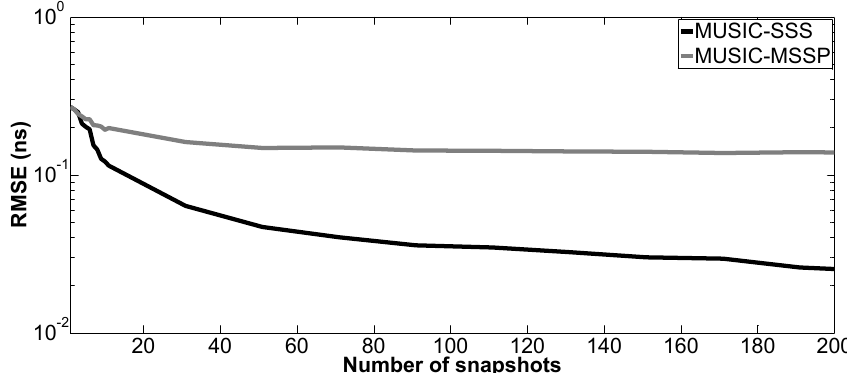
Figure 10. RMSE on the estimated time delay ˆ t 2 versus the number of snapshots.